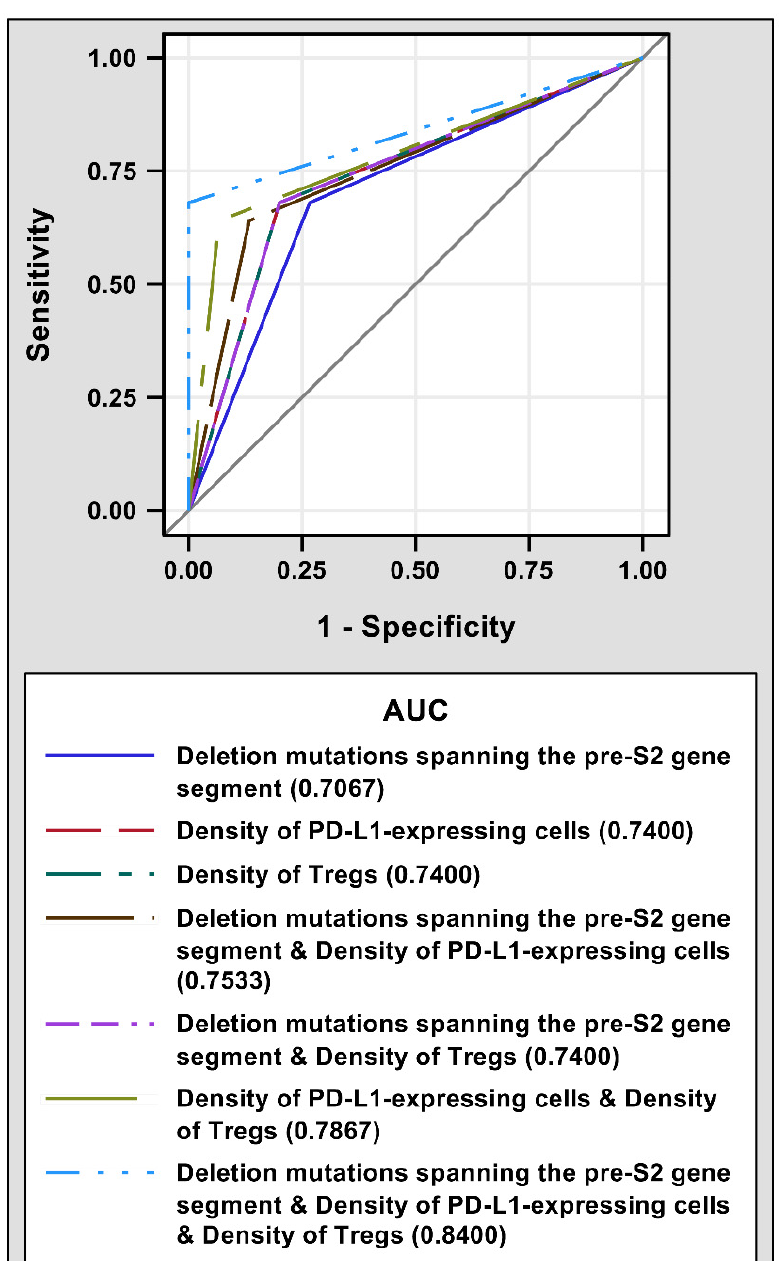
Figure 2. ROC curves of different prognostic biomarkers for HCC recurrence after curative surgical resection. 25 patients with and 15 patients without post-operative HCC recurrence were analyzed. The AUCs for deletion mutations spanning the pre-S2 gene segment (solid dark blue line), density of PD-L1-expressing cells (dashed red line), density of Tregs (dashed dark green line), a combination of deletion mutations spanning the pre-S2 gene segment and density of PD-L1-expressing cells (dashed brown line), a combination of deletion mutations spanning the pre-S2 gene segment and density of Tregs (dashed purple line), a combination of density of PD-L1-expressing cells and density of Tregs (dashed light green line), and a combination of deletion mutations spanning the pre-S2 gene segment, density of PD-L1-expressing cells, and density of Tregs (dashed light blue line) were shown in the bottom of the plot. Abbreviations: ROC, receiver operating characteristic; HCC, hepatocellular carcinoma; AUC, area under the ROC curve; PD-L1, programmed death ligand 1; Tregs, regulatory T cells.